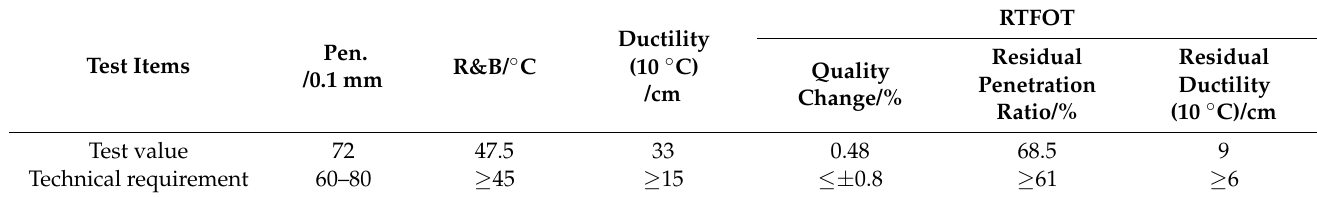
Table 1. Performance indexes of base